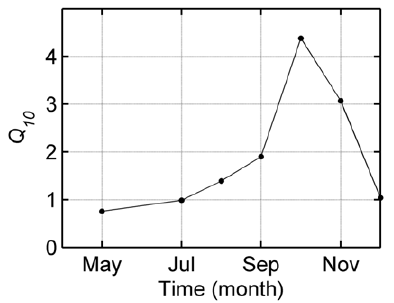
Figure 5. Seasonal sensitivity of soil respiration to soil temperature ( Q 10 ). Data points were derived from exponential regression over monthly time period as shown in figure 4.